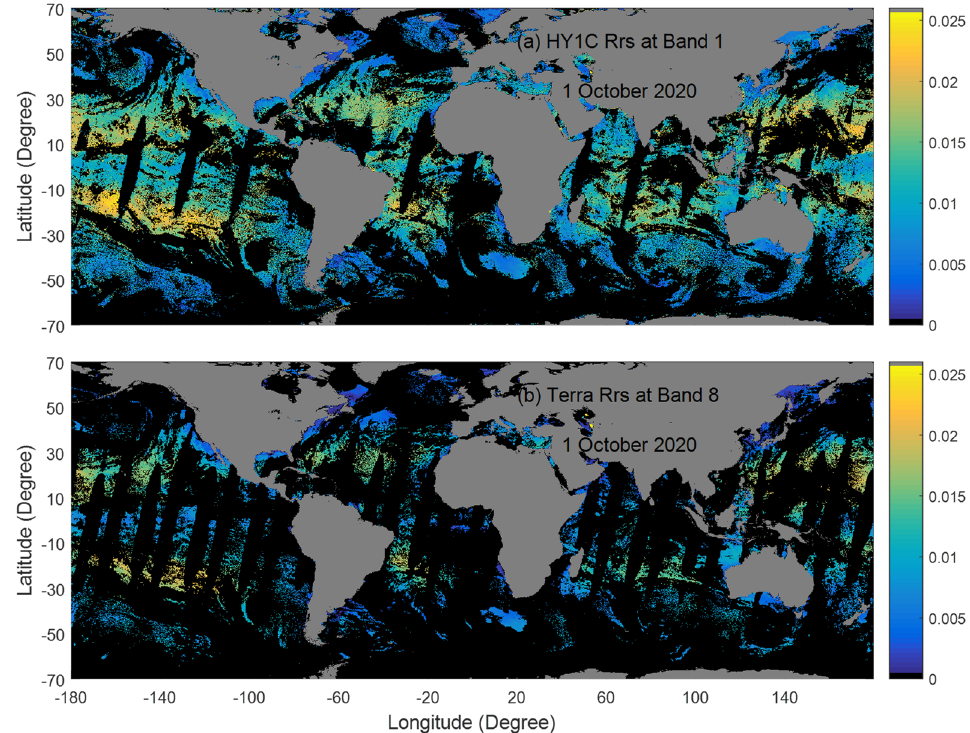
Figure 4. The comparison of the global daily R rs image on 1 October 2020 with ( a ) COCTS/HY-1C at Band 1 and ( b ) MODIS/Terra at Band 8. The magnitudes of image pixels are indicated by the color bar with the unit of sr − 1 . Invalid pixels are masked black and land grey.